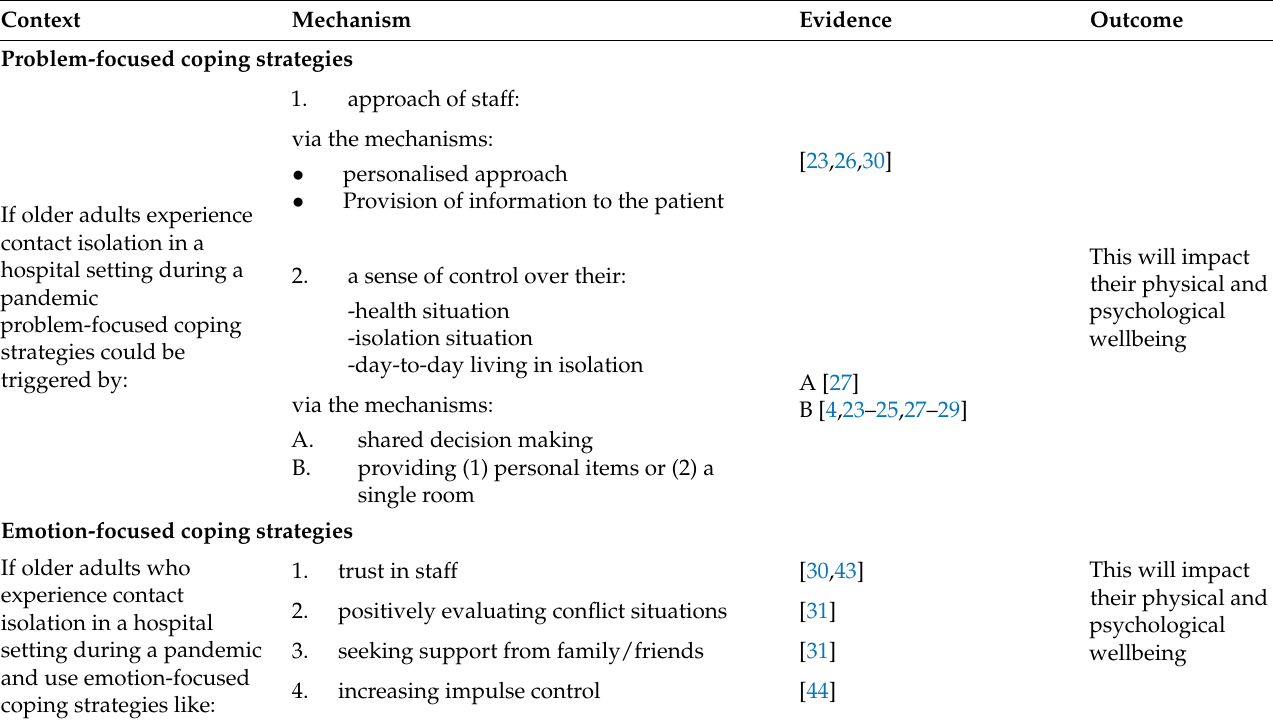
Table 1. Initial program